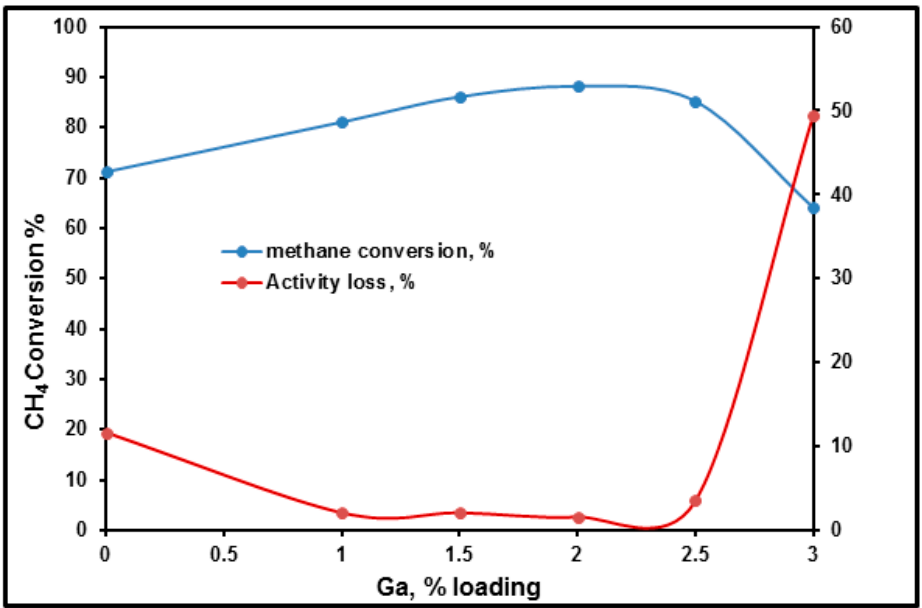
Figure 8. Effect of Ga loading on CH 4 conversion and deactivation over 400 min on stream at 800 °C reaction temperature, at atmospheric pressure, CH 4 :CO 2 = 1:1 in the feed gas, catalyst weight: 0.1 g, WHSV: 21,000 mL g − 1 h − 1 .